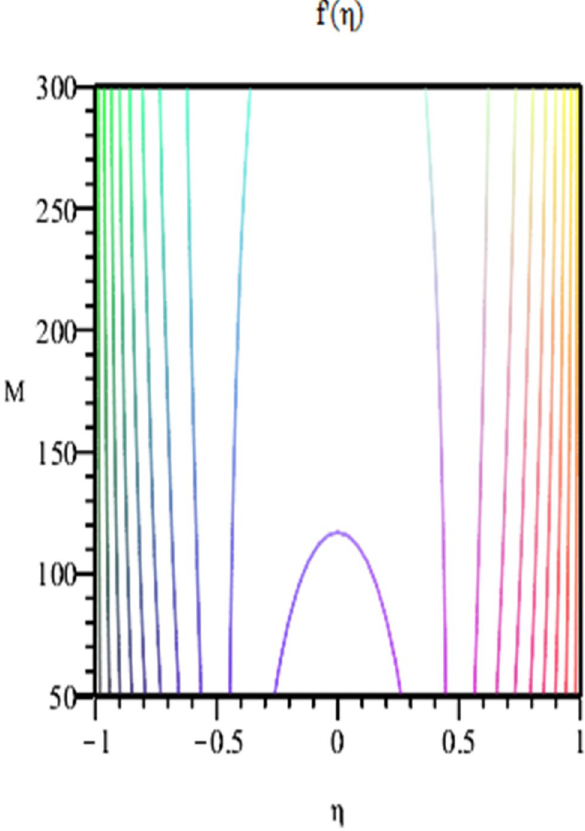
Figure 11. Contour of Radial velocity for ϕ 1 = ϕ 2 = 0.01, Sc = 1, α = 3, Re = − 1, Pr = 6.2 .